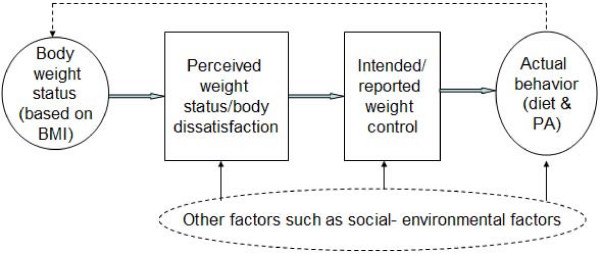
Conceptual framework: Body weight, perceived weight status, body dissatisfaction, and weight control practices*. *NOTE: The present study is not aimed to examine the impact of the "other factors" due to its scope and our available data.